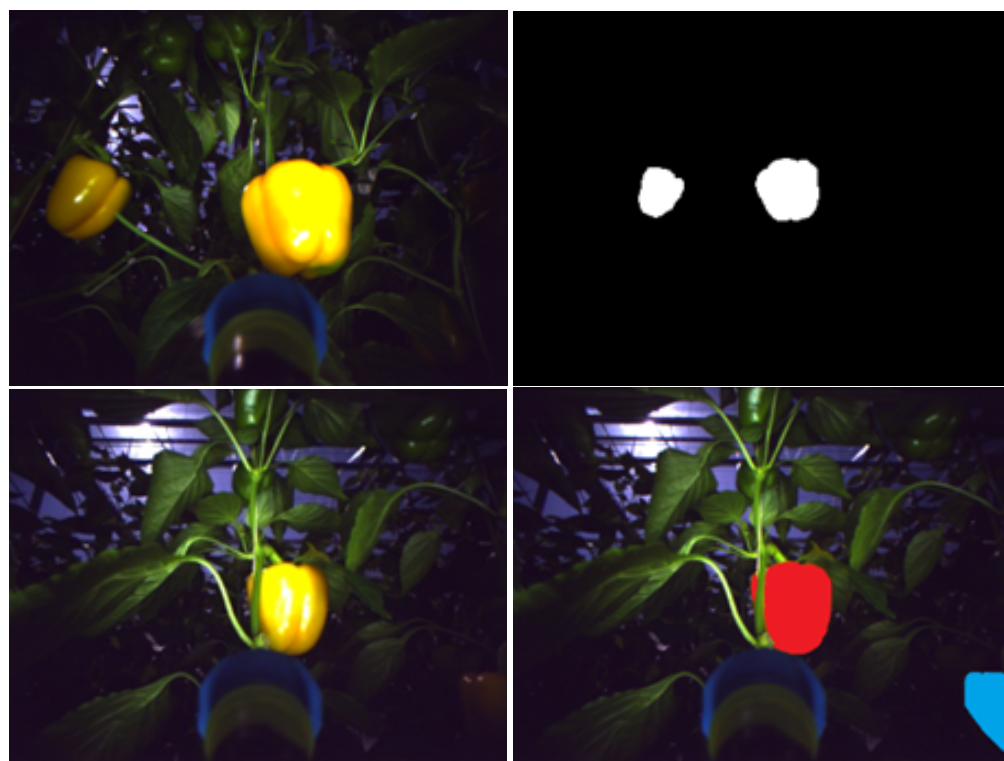
Figure 3. Peppers tagging example. Top : RGB image ( left ) and ground truth ( right ) example in high visibility. Bottom : RGB image ( left ) and labeled image ( Right ). “High-visibility peppers” marked in red and “low-visibility peppers” marked in